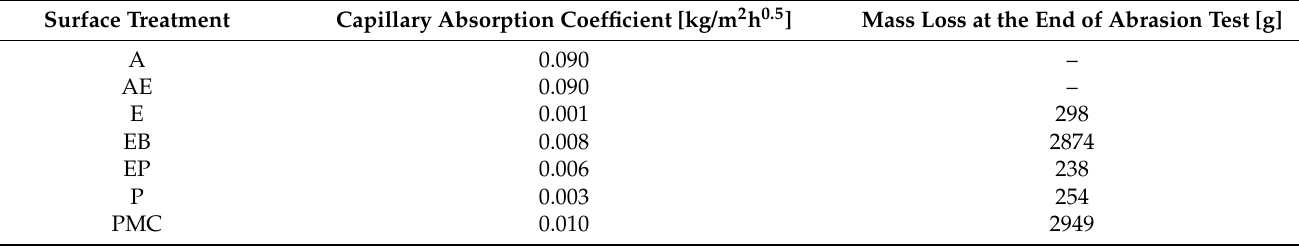
Figure 3. Resistance against water vapor permeability of coatings expressed in terms of Sd vap (left) and µ vap (right). Sd CO 2 is calculated as the product of µ vap and the application thickness (t). Table 5. Capillary absorption coefficient and results of abrasion